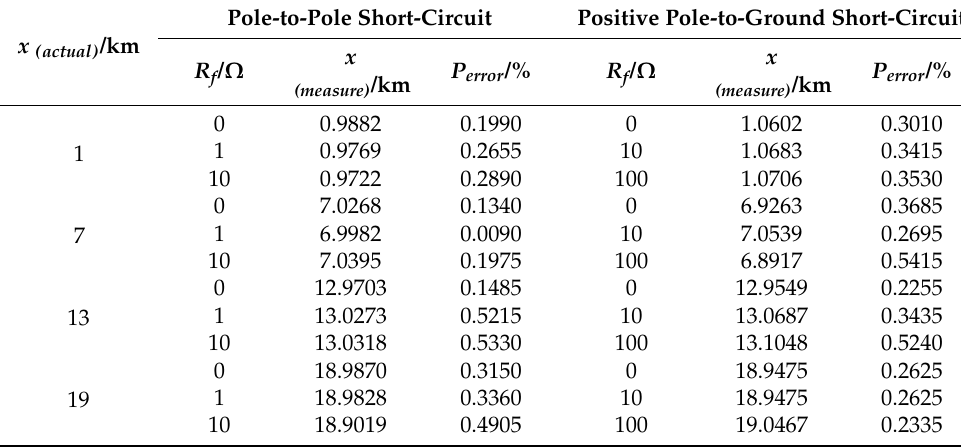
Table 1. Simulation results for different fault resistances and fault locations.